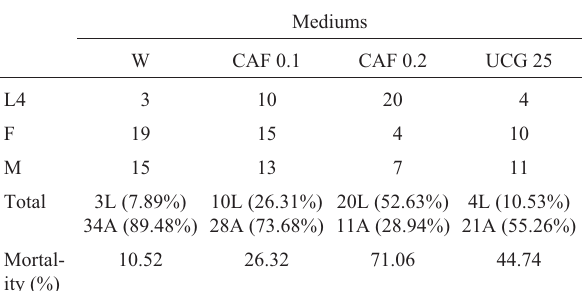
Table 3 - Results of experiments using L3 larvae (38 per experiment). Number of L4, female (F) and male (M) adults produced and mortality (in percentage), in the treatments with water (W), caffeine (CAF) at 0.1 mg/mLand0.2mg/mLandusedcoffeegrounds(UCG)at25mg/mL.Fish food was added to the